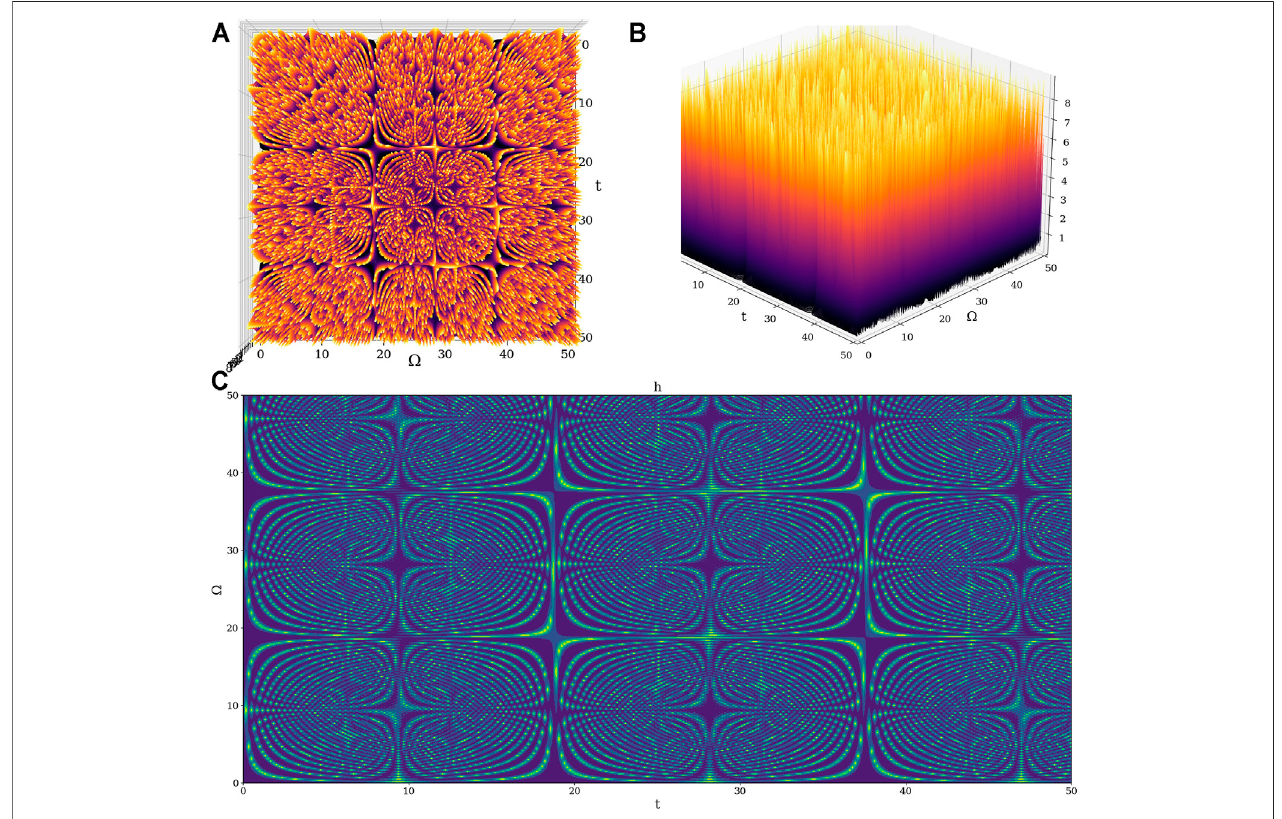
FIGURE 1 | Example 3D plot of h ( Ω , t ) ; (A) Φ (cid:2) 2 . 35, (B) (top, i.e., positive values); Φ (cid:2) 2 . 35 and (C) example 2D plot of h ( Ω , t ) ; Φ (cid:2) 2 . 35.